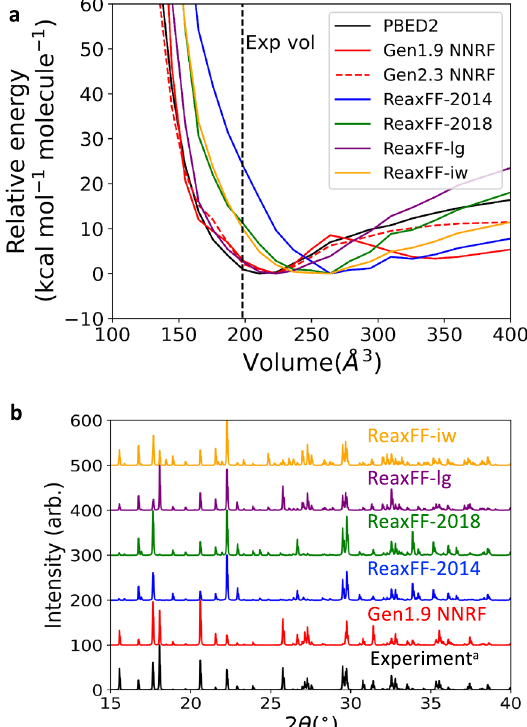
Fig. 7 Structural properties of available force fi elds. a Equation of state for RDX crystal with experimental volume (Exp vol indicated as a vertical dashed line, corresponding to ρ = 1.86 g cm − 3 ) and b The X-ray diffraction peaks of RDX crystal from Experiment and available force fi elds (Gen1.9 NNRF, ReaxFFs). a Experimental RDX crystal structure from ref. 78